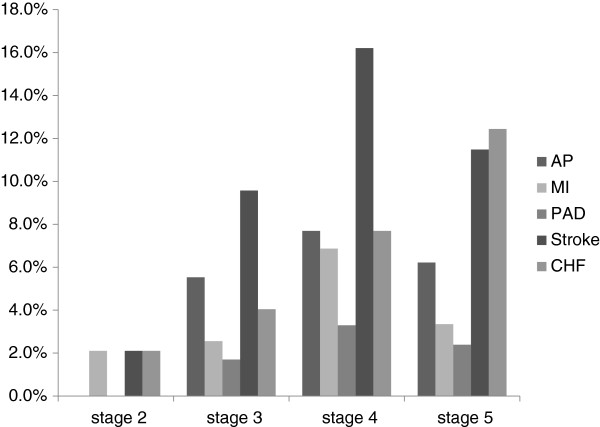
Prevalence of individual causes of cardiovascular disease (CVD) stratified by CKD stages, the CKD-ROUTE study (Oct 2010 - Dec 2011). Angina pectoris (AP), myocardial infarction (MI), peripheral arterial disease (PAD) and stroke were highest in patients with stage 4 CKD; congestive heart failure (CHF) incidence gradually increased with CKD progression.